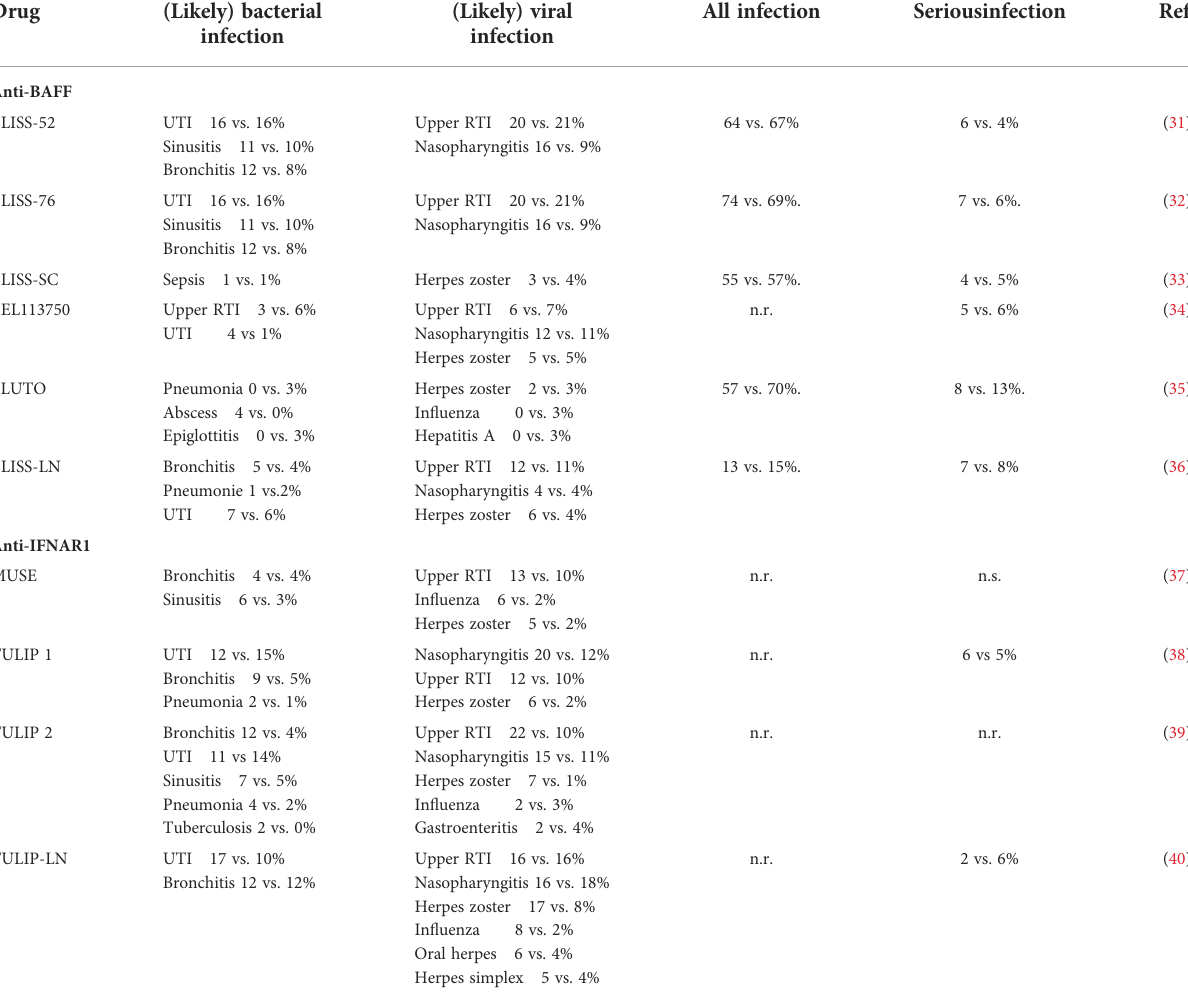
TABLE 2 Infection-related safety data of anti-BAFF and anti-IFNAR1 from large RCTs. Drug (Likely) bacterial (Likely) viral All infection Seriousinfection infection infection